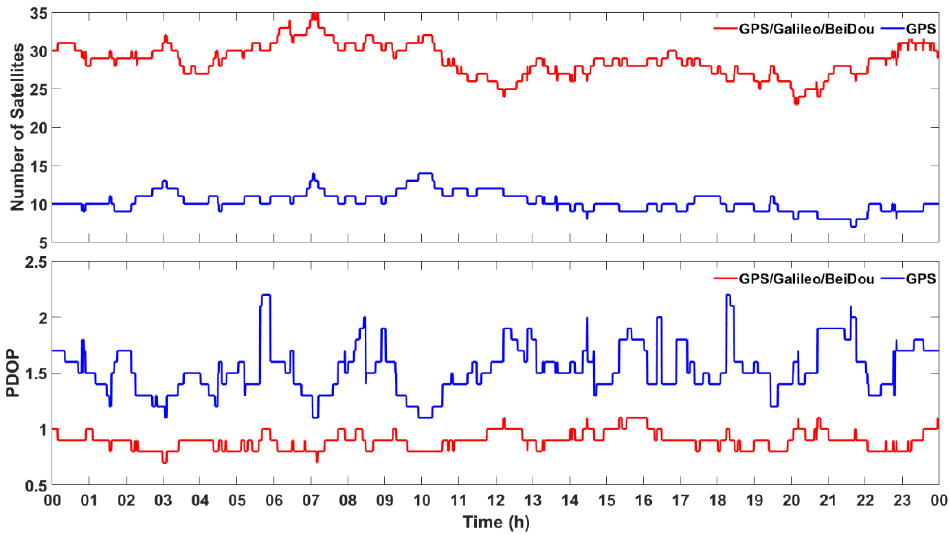
Figure 3. Number of visible satellites ( Top ) and positional dilution of precision (PDOP; Bottom ) obtained at HKLT station by using only GPS satellites and GPS/Galileo/BeiDou ones, respectively. The signal-to-noise ratio (SNR) and pseudorange multipath (MP1/MP2) by